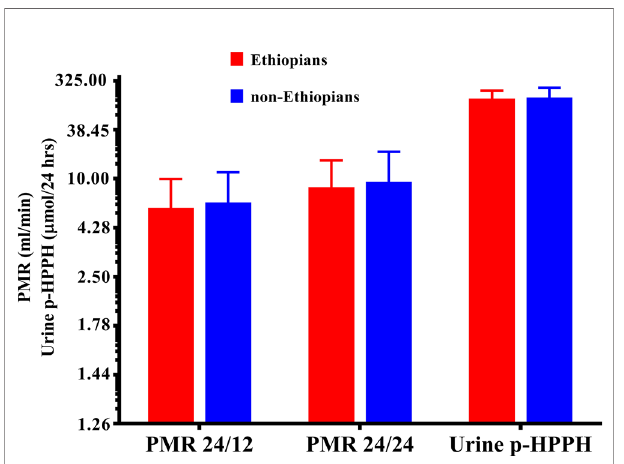
FIGURE 3 | The molar amount of p-HPPH in 24 urine collection, PMR24/12 and PMR24/24 in Ethiopian carriers of rs12777823 GG (yellow bars), GA (yellow hatched bars), and AA (black bars) genotypes. Log 10 transformed data was used for comparison with anti log 10 values presented on the y-axis. (Statistical comparison between carriers of different rs12777823 genotypes was performed by ANOVA on log 10 transformed data).